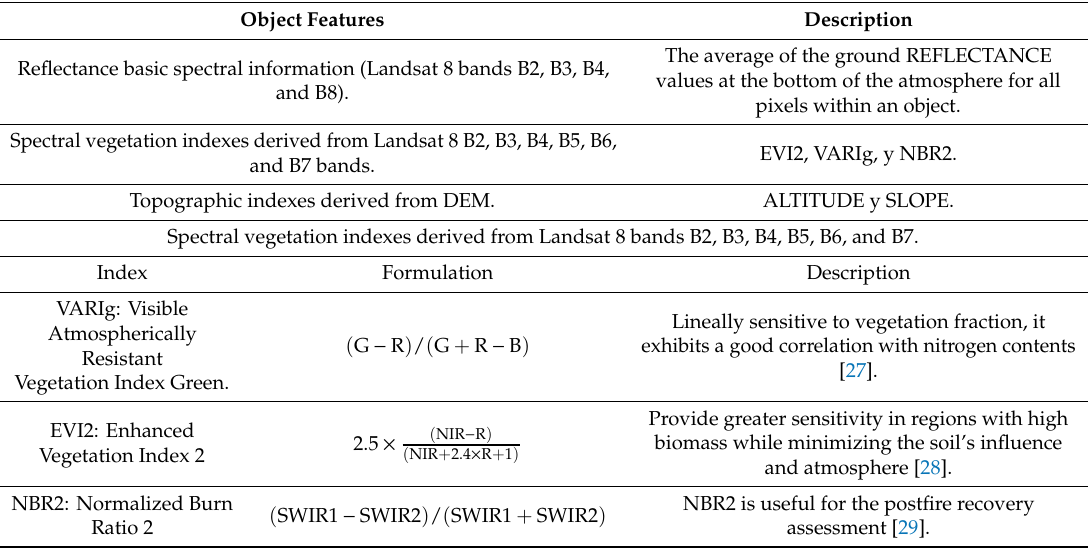
Table 1. Features used for classification